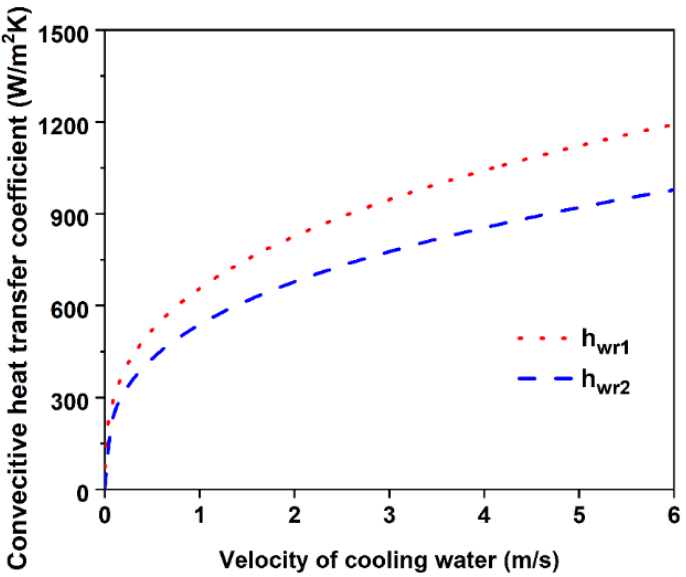
Figure 4. Curves of convective heat transfer coefficients varied with velocity of cooling water. Table 1. Physical parameters of cooling water at 20 °C [19] (p. 563).